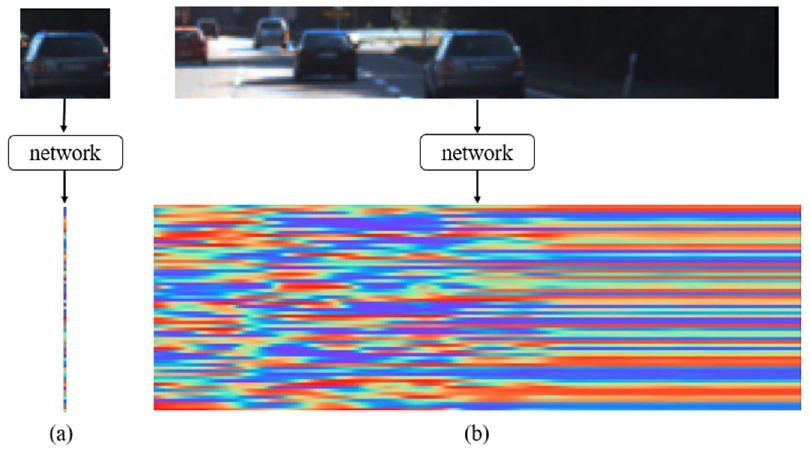
Figure 3. Visualized data of the feature map of both networks for calculating similarity score.